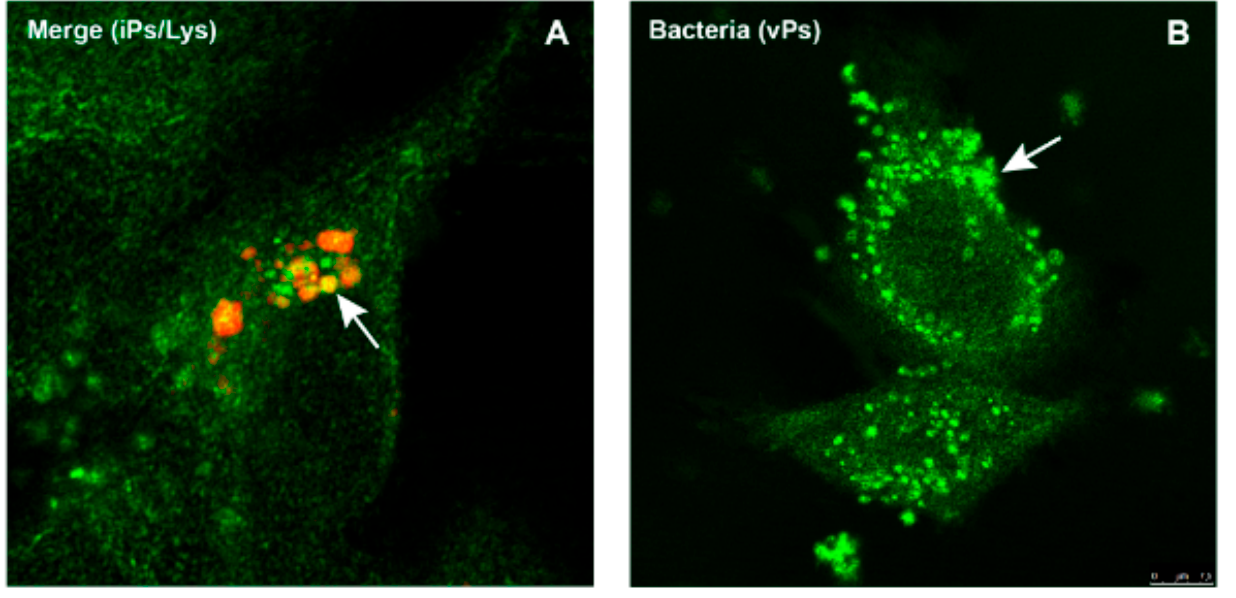
Figure 9. Colocalization of P. salmonis (virulent and inactivated) with lysosomes in SHk-1 cells. Intracellular localization of virulent P. salmonis LF89 (vPs) and formaldehyde-inactivated (iPs) strains within SHK-1 macrophages was evaluated by confocal microscopy. The confocal micrograph (panel ( A )) shows inactivated P. salmonis (iPs) (in green) colocalized within lysosomes (red). The colocalization is visualized with a color between yellow and orange. This indicates the phagosome maturation of infected cells. (Panel ( B )) shows a virulent strain of P. salmonis (vPs) (in green) that does not colocalize with lysosomes. VPs strains remain in their phagosome and do not mature to the P-L fusion, surviving and proliferating in macrophages.